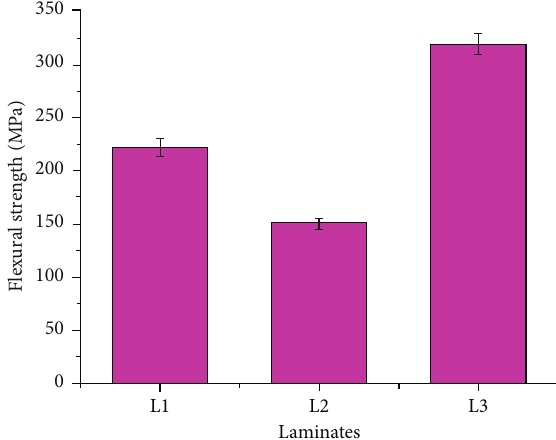
Figure 7: Representation of flexural strengths of different